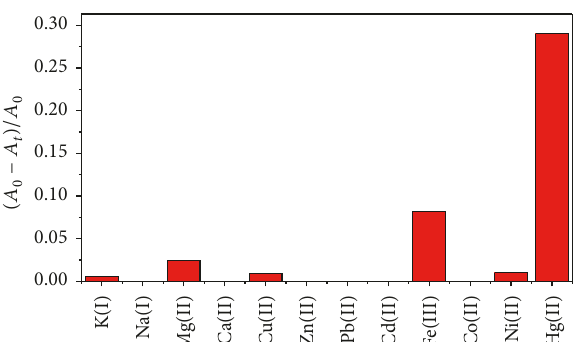
Figure 5: Colorimetric response of starch-stabilized AgNPs recorded 5 min after the addition of 5 × 10 −5 molL −1 metal